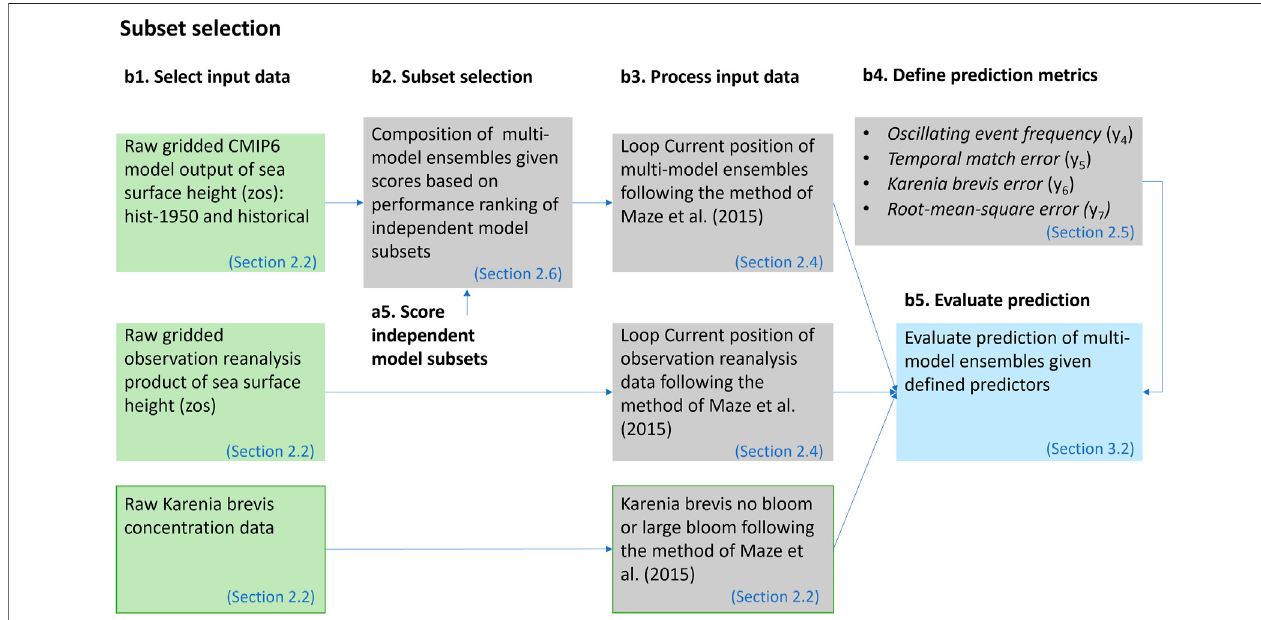
FIGURE 4 | The subset-selection